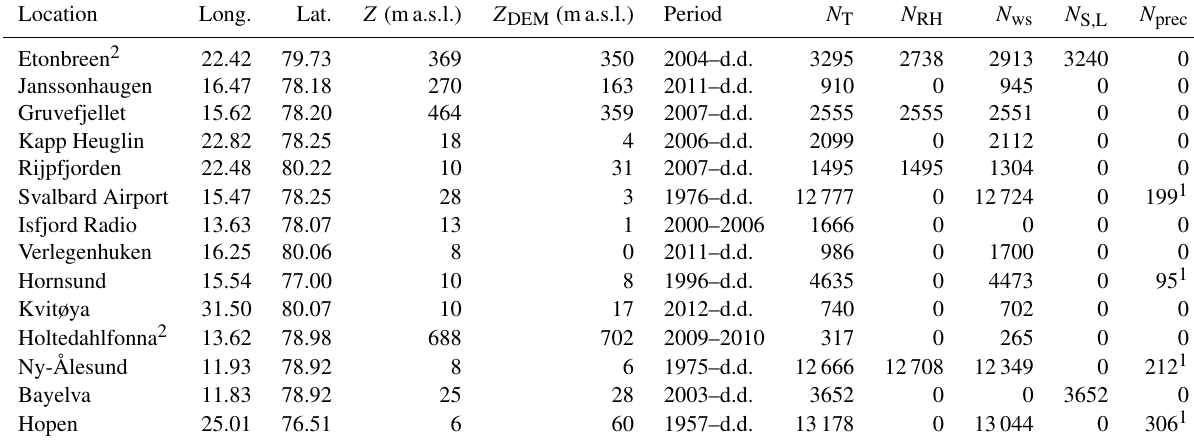
Table 1. Meteorological stations used for validation of the downscaled ERA-Interim reanalysis. N indicates the number of daily averages used in the validation, subscript T refers to 2m air temperature, RH is relative humidity, ws is wind speed, L and S is downwelling short- and longwave radiation and prec is precipitation. Also given is the elevation of the observation site ( Z ) and the closest grid point ( Z DEM ). Location Long. Lat.